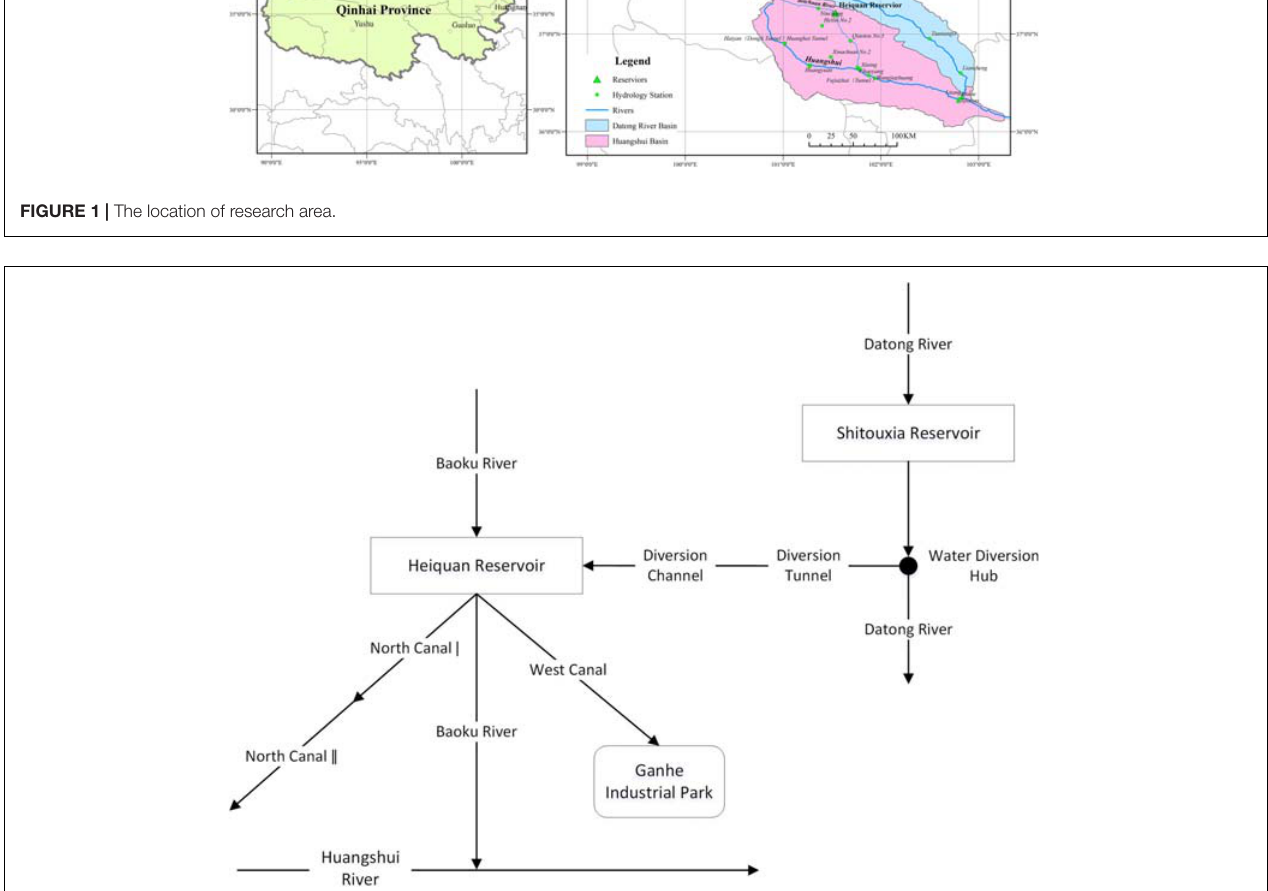
FIGURE 2 | The hydraulic connection of the “Datong-Huangshui” water transfer